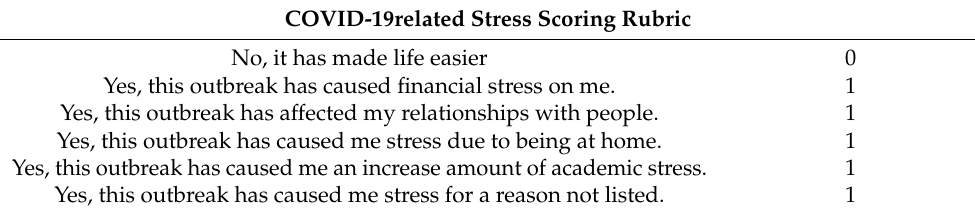
Table A7. COVID-19-related stress assessment for surveys. Participants were told to select all that applied, and scores were cumulative based on their